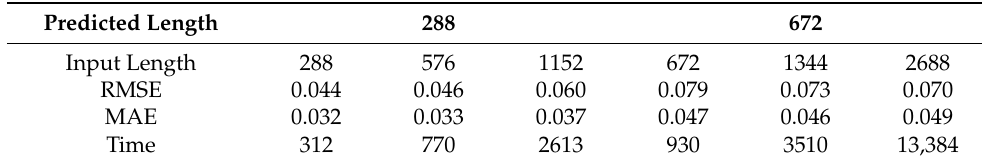
Table 3. Effects of different input–output ratios on model performance.